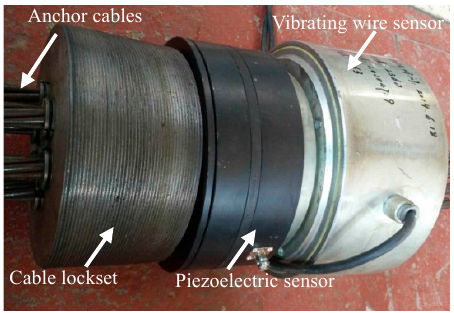
Figure 11. The connection form of the sensing system.